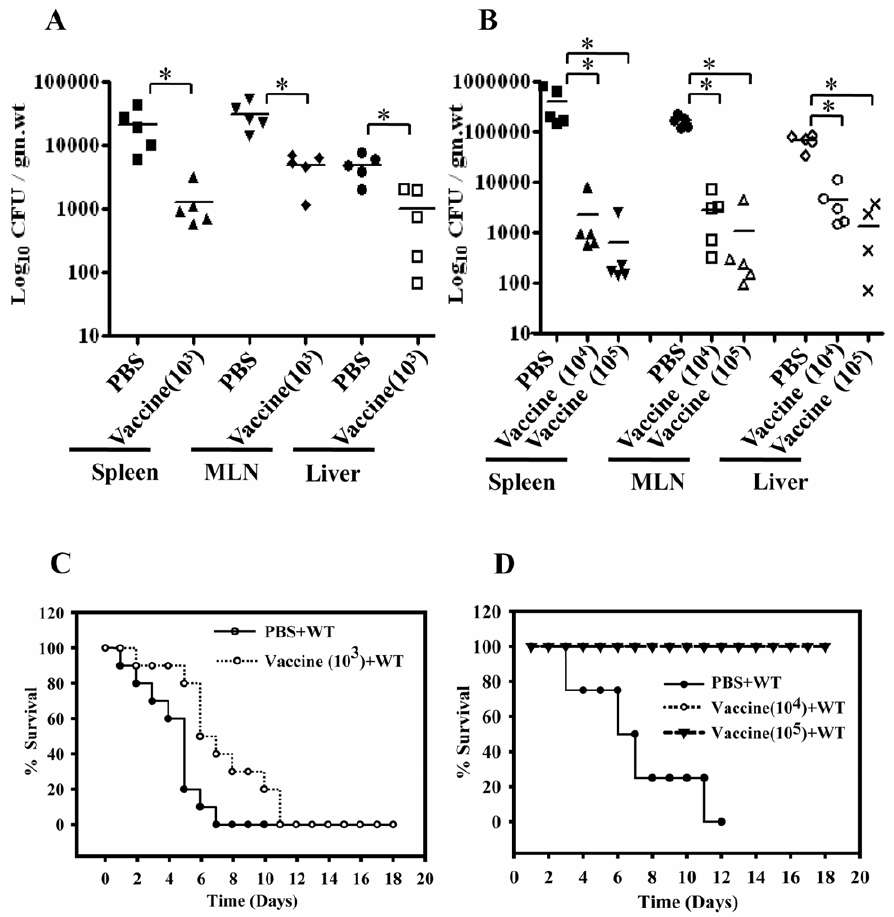
Figure 3. Multiple immunizations with STM D hfq confer protection against virulent Salmonella . Groups of 5 mice were immunized orally with 10 3 (A&C), 10 4 or 10 5 (B&D) STM D hfq for two booster doses followed by challenge with WT through oral route (for organ load: 10 7 and for survival analysis: 10 8 of WT) 7 days after the final booster dose. Control mice received PBS. 7 days after challenge, mice were sacrificed and bacterial load in different organs was enumerated using direct cultures of serially diluted homogenized samples. A&B depict bacterial load in different organs and C&D shows survival curves. Result presented is one of two independent experiments performed. Statistical significance was defined as follows * p , 0.05; ** p , 0.005 (Mann-Whitney U test & Fischer’s exact